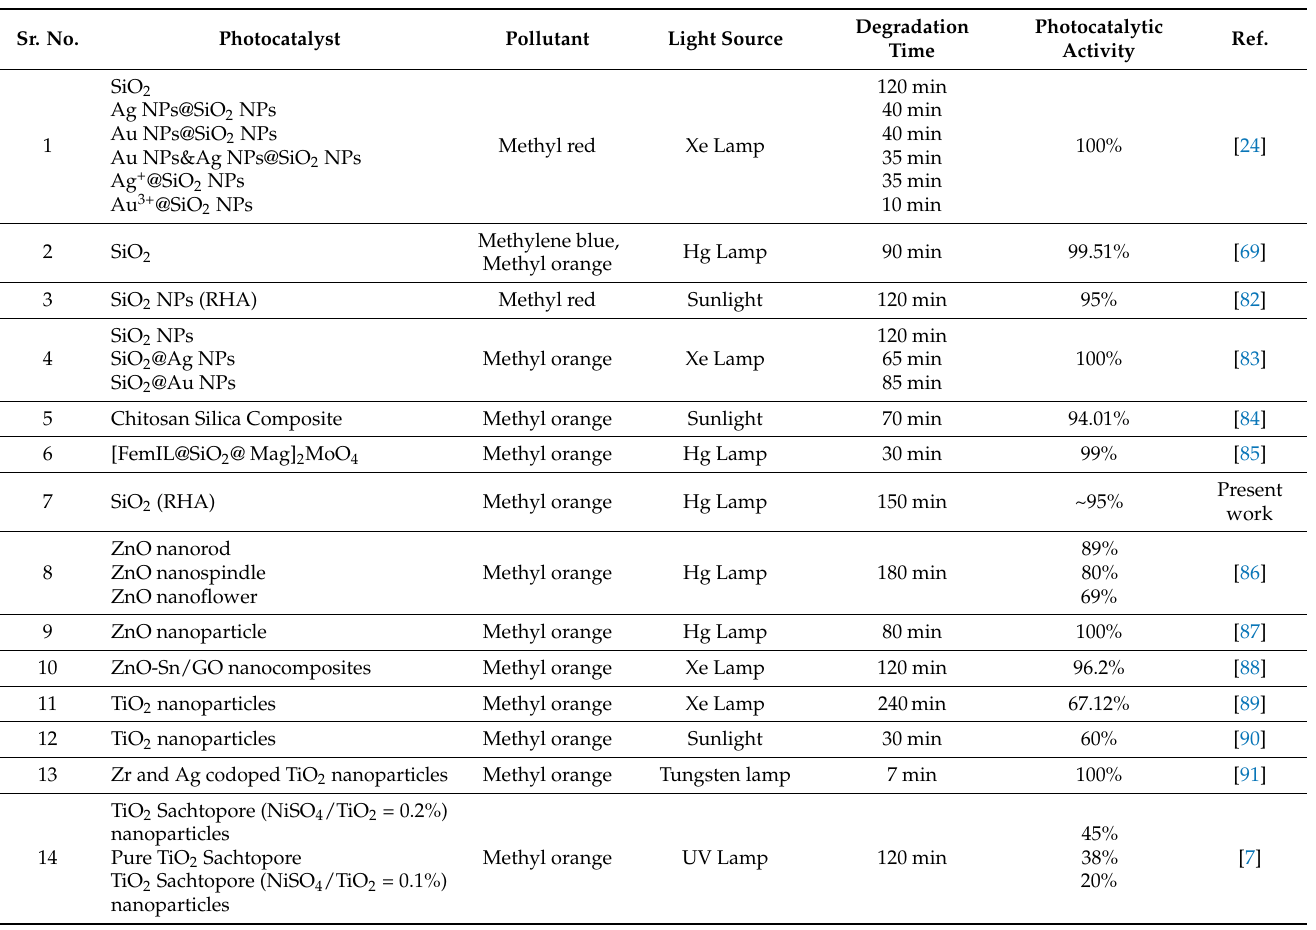
Table 4. Comparison of photocatalytic performances of the synthesized SiO 2 NPs from RHA and systems-based SiO 2 NPs and different photocatalysts for dye degradation at different photodegrada- tion